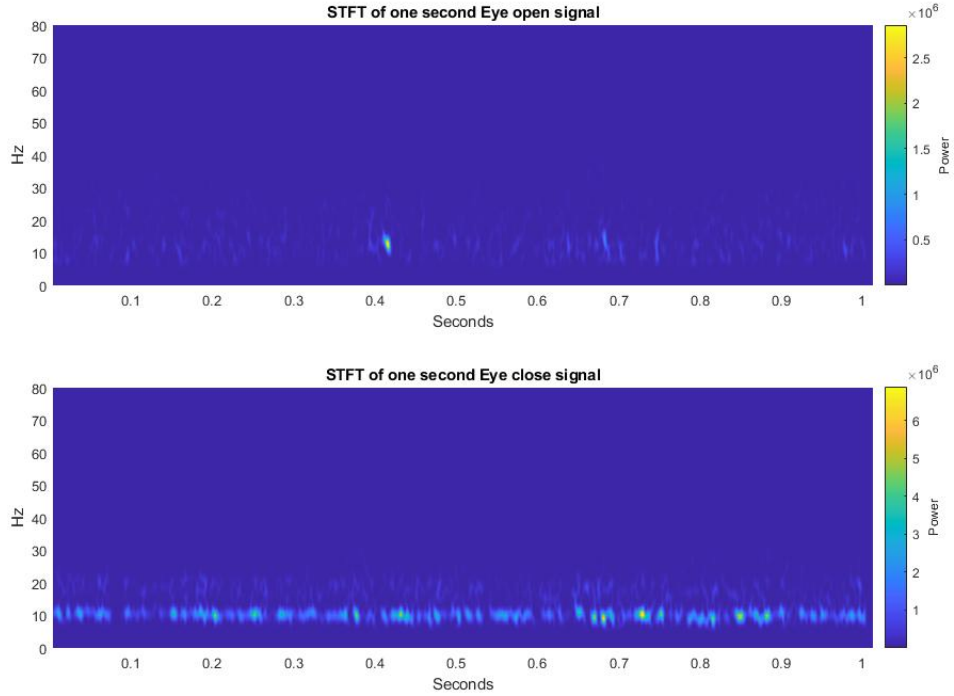
Figure 6. The comparison of eye-open and eye-close signals after STFT.